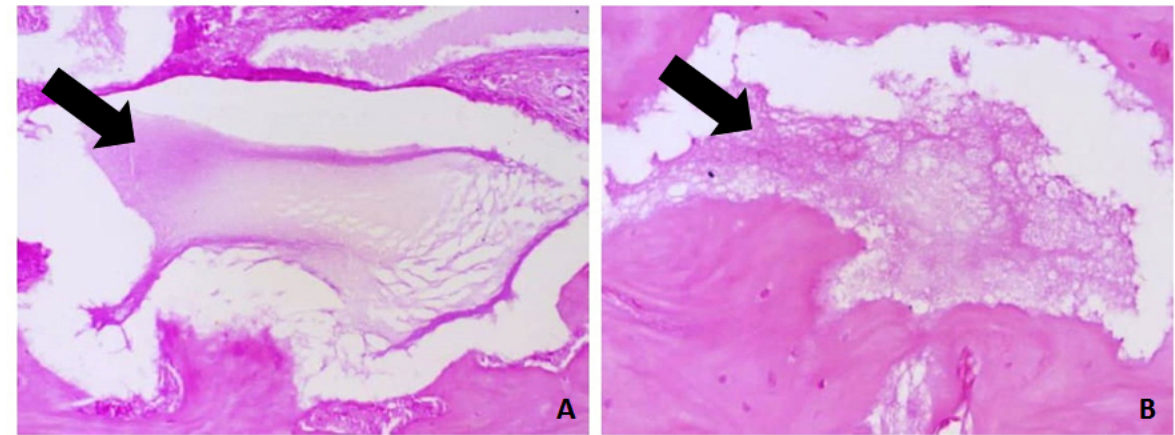
Figure 15. Progressive resorption of calcium phosphate granules at receptor site: (A) 30 and (B) 60 days after implantation. Sections stained with hematoxylin and eosin.